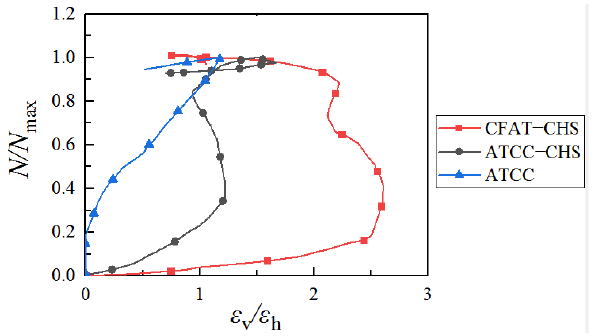
Figure 15. N / N max - ε v / ε h relationships.